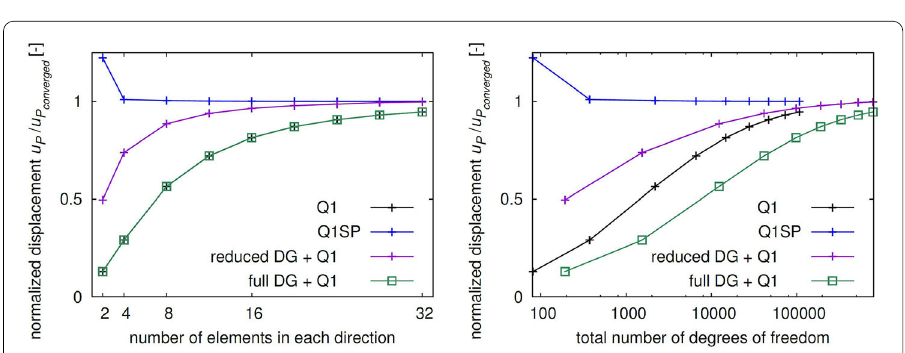
Fig. 11 Normalized vertical displacement of the point P in the 3D block as a function of the number of elements in each direction (left) and total degrees of freedom (right) for Q1, Q1SP, DG and their combinations with η = 10 7